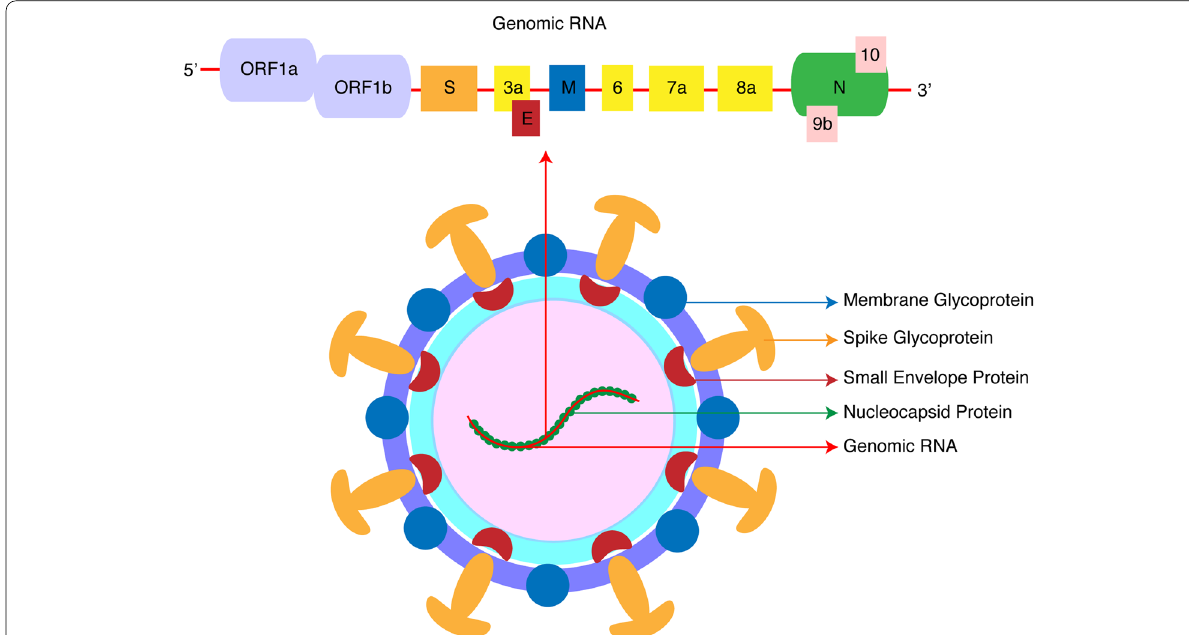
Fig. 1 Schematic representation of the structure of SARS-CoV-2 virus. SARS-CoV-2 is a RNA virus primarily made up of spike (S), membrane (M), envelope (E), and nucleocapsid (N) structural proteins embedded in the lipid bilayer of the viral envelope. The N glycoprotein is associated with the virion’s genomic RNA, which is approximately 30 kb. In addition, SARS-CoV-2 consists of non-structural and other open reading frames (ORFs) that are believed to help the virus in establishing its infection and various steps of COVID-19 disease